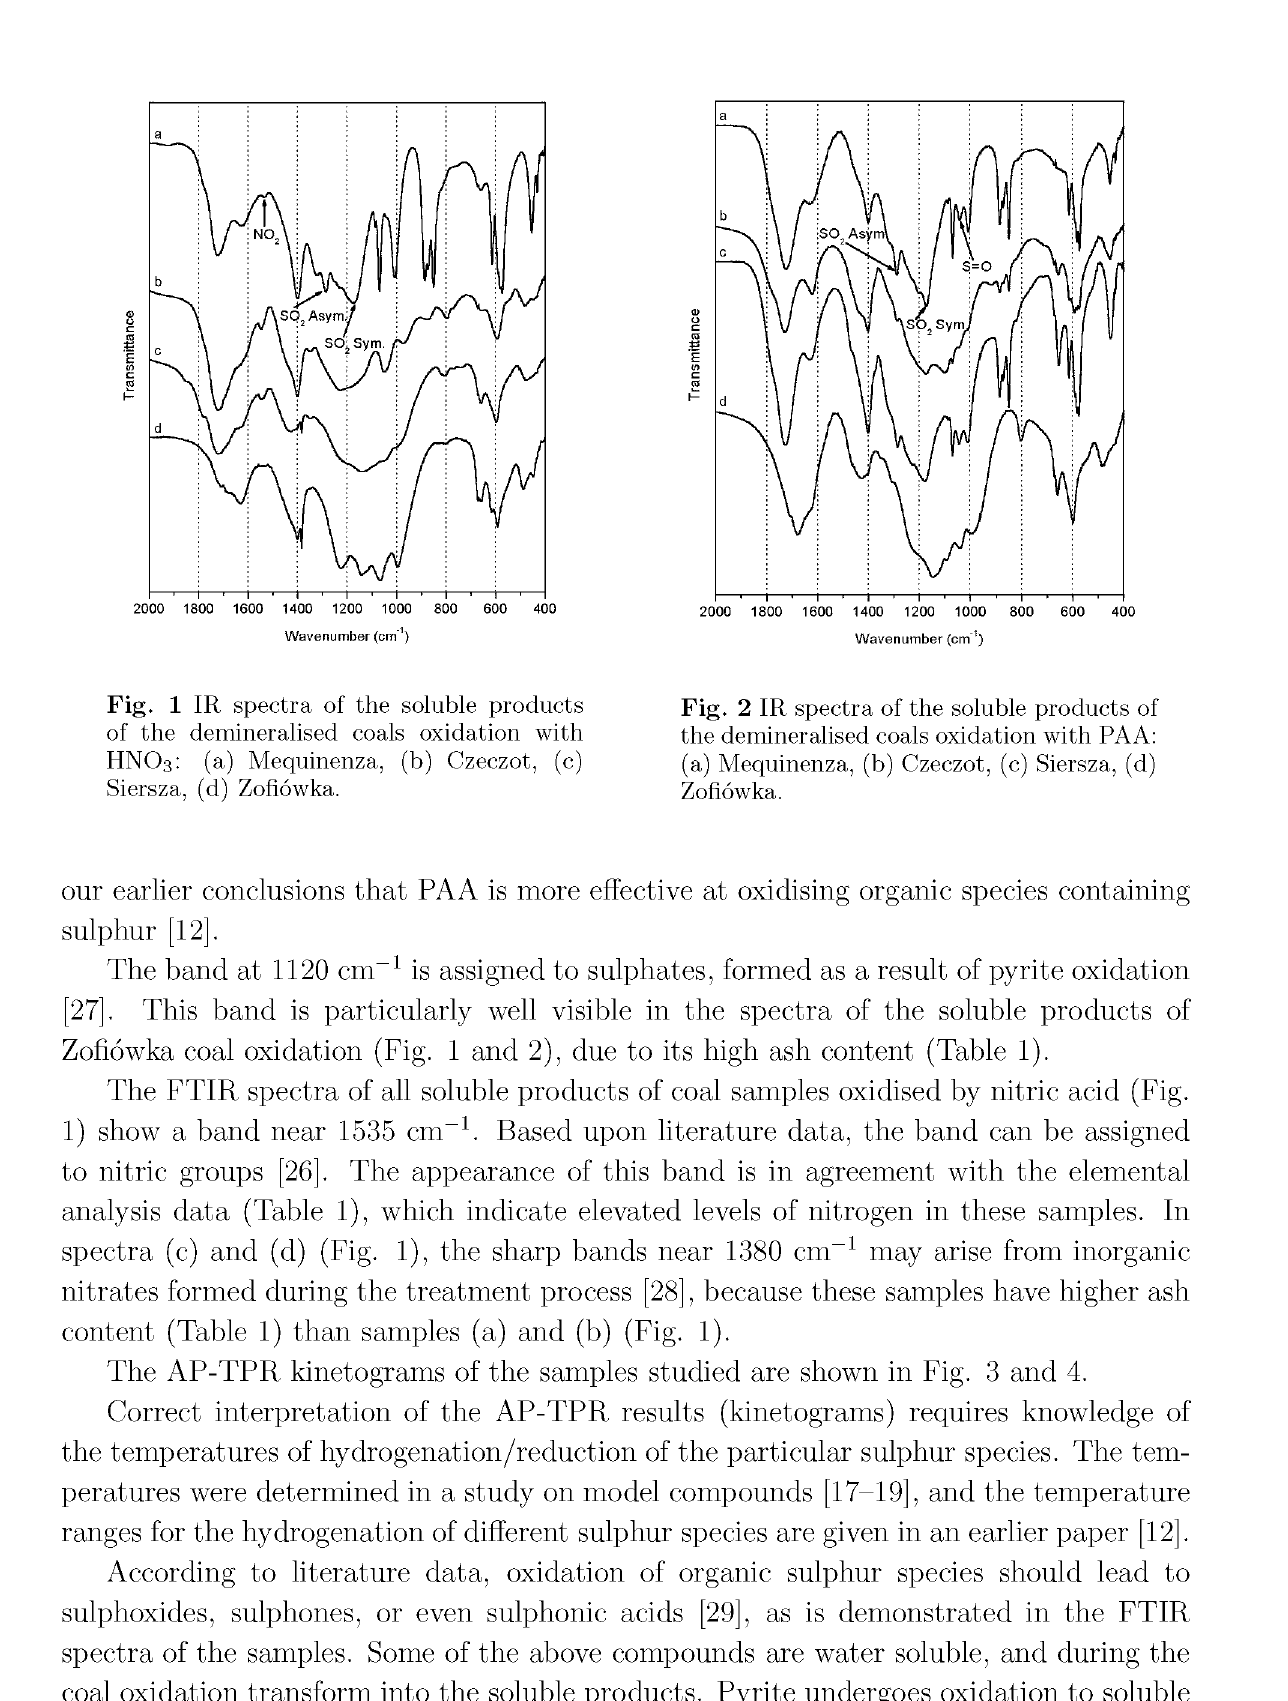
Fig. 1 IR spectra of the soluble products of the deinineralised coals oxidation with HNOa: (a) Mequinenza, (b) Czeczot, (c) Siersza, (d) Zofi6wka.